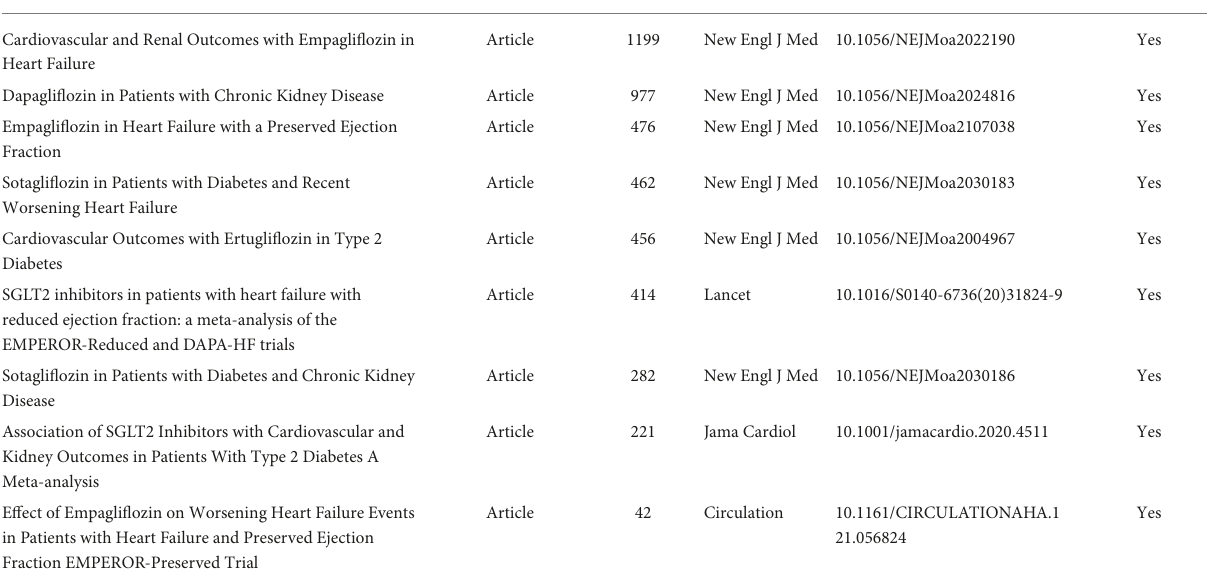
TABLE 7 The total nine hot papers in the field of EMPA for